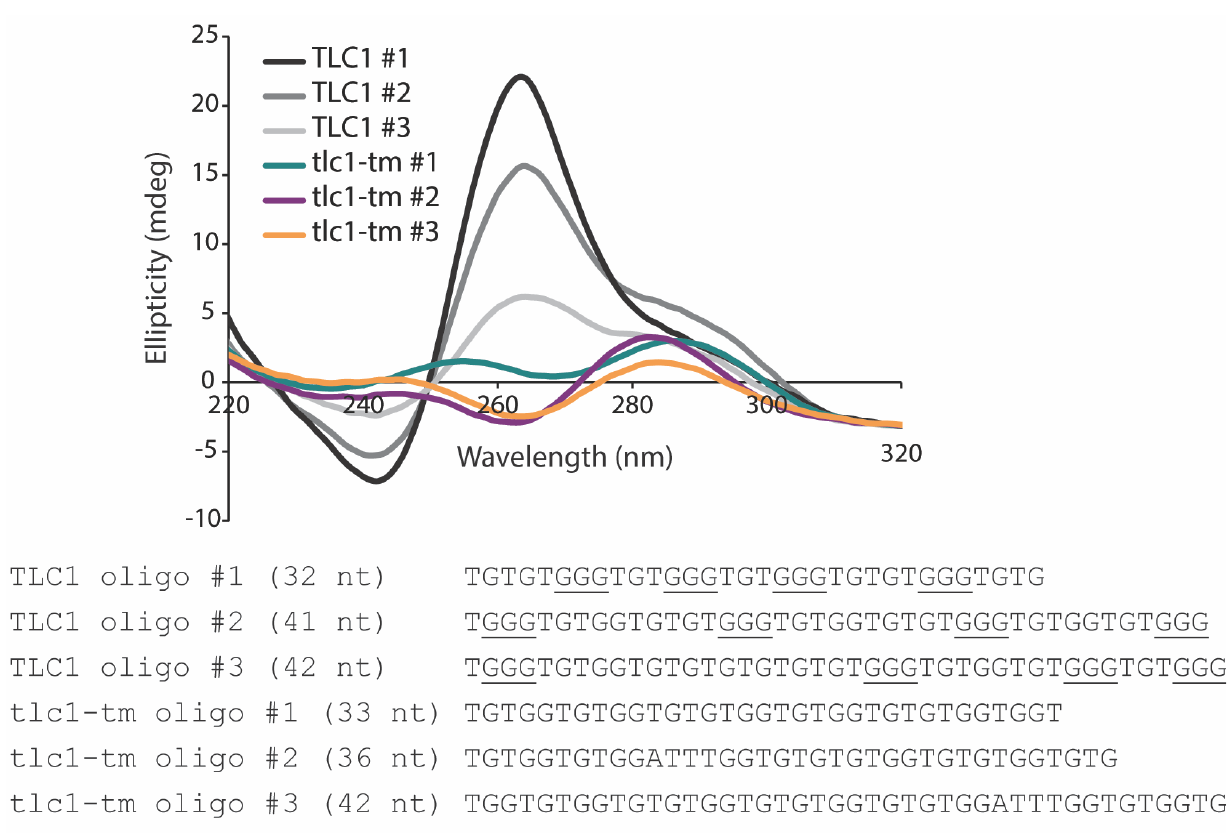
FIGURE 1: tlc1-tm mutant telomere sequences are impaired in forming G-quadruplexes. CD spectra of oligonucleotides with either wild- type or tlc1-tm telomeric sequence. Average of three measurements is